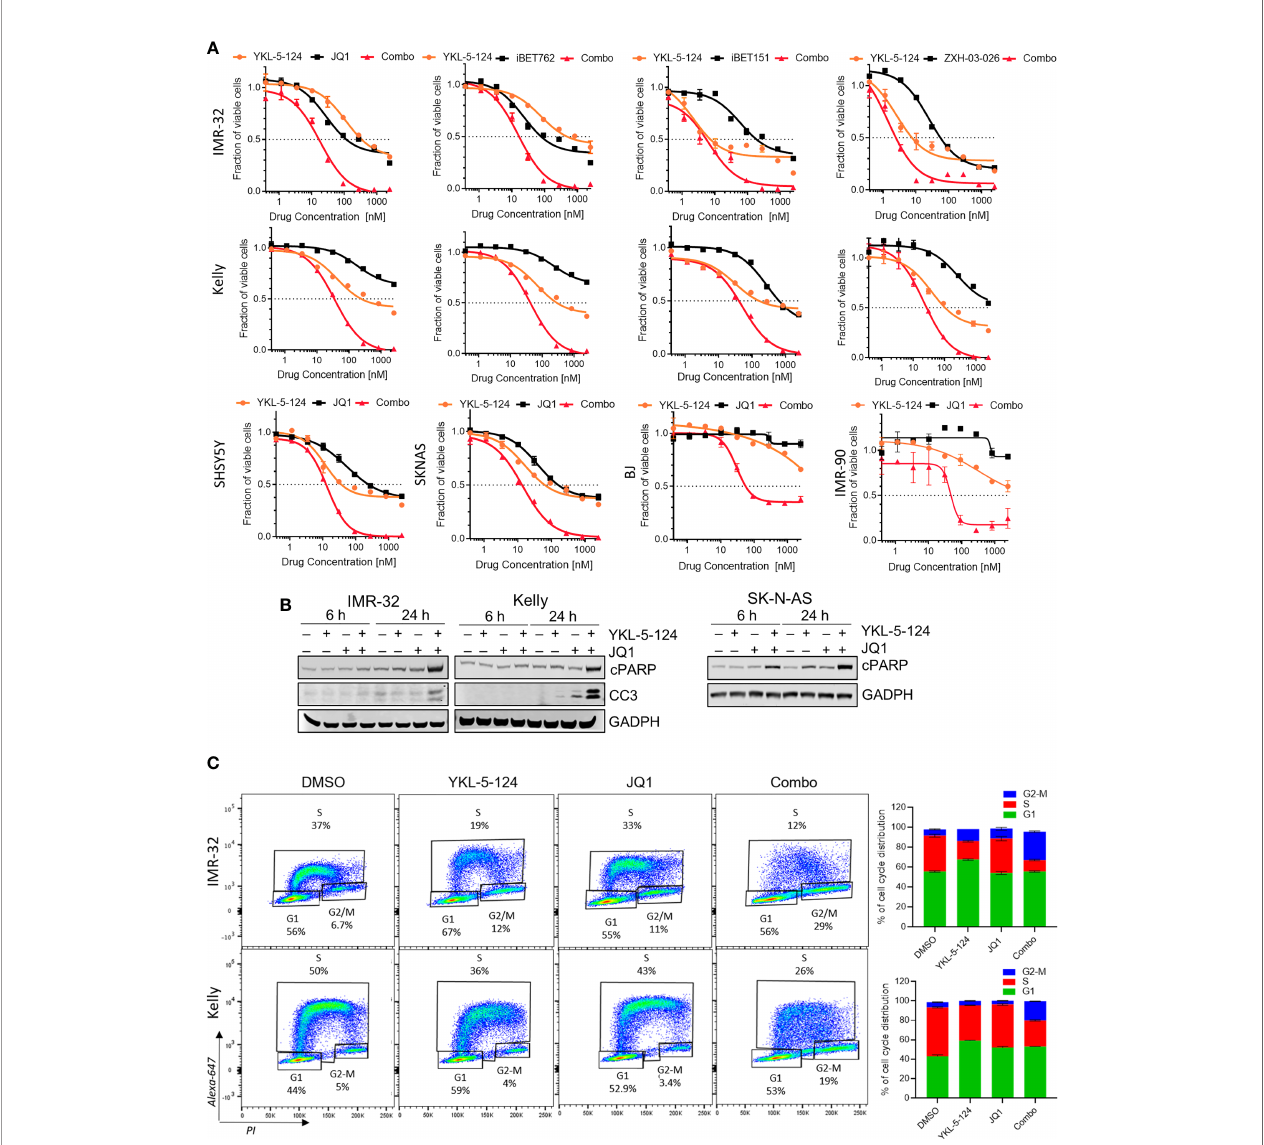
FIGURE 3 | The addition of BRD4 inhibitors to YKL-5-124 leads to cytotoxicity in NB cells. (A) Dose-response curves for NB cells and BJ and IMR-90 fi broblast cells treated with YKL-5-124 and the indicated BRD4 inhibitors (JQ1, iBET762, iBET151) or degrader (ZXH-03-026), singly or in combination for 72 h. For the combination (combo), cells were treated with YKL-5-124 and BRD4 inhibitor (as indicated on the graph) at a constant ratio of 1:4. (B) WB analysis of apoptosis markers in NB cells treated with 100 nM YKL-5-124, 400 nM JQ1 or the combination at the indicated time points. (C) Flow cytometry analysis of EdU staining in NB cells treated with DMSO, 100 nM YKL-5-124, 400 nM JQ1 or the combination for 24 h (left). Percentages of living cells in each phase of the cell cycle are shown. Quanti fi cation of staining (right), data represent mean±SD; n